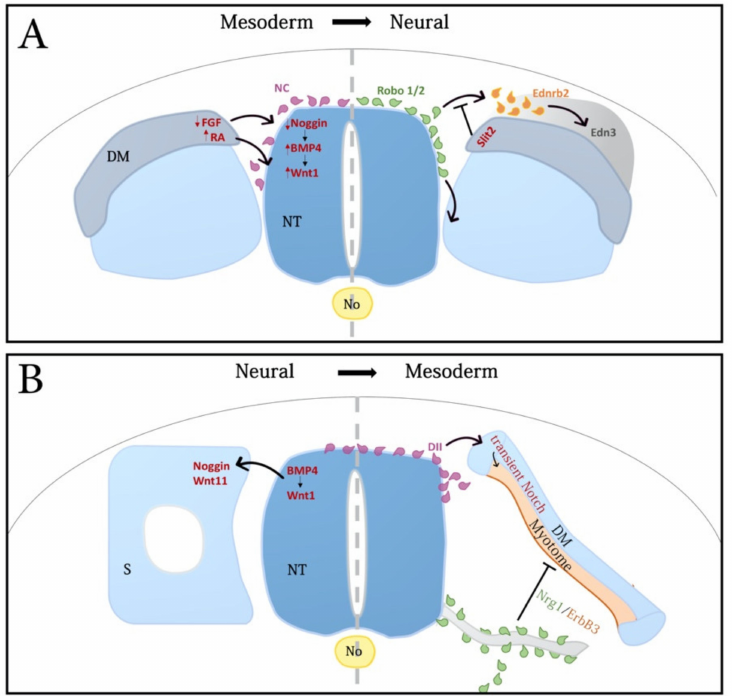
Figure 1. NC-mesoderm interactions. ( A ) Left side: The medial lip of the nascent dermomyotome (DM) controls the timing of NC delamination. In the early dorsal neural tube (NT), prior to the onset of NC emigration, levels of noggin are high, in part due to somite-derived FGF signaling, thereby inhibiting the activity of BMP4 and consequent NC delamination. During somite dissociation, decreasing FGF signaling results in reduced transcription of noggin in the dorsal NT. Consequently, inhibition on BMP4 is relieved, Wnt1 transcription is stimulated and NC emigration is set in motion. In parallel, increasing retinoic acid (RA) levels in the DM act upon the dorsal NT to induce Wnt1 and trigger NC cell emigration (purple cells). ( A ) Right side: The DM and later dermis influence the choice of pathways followed by NC cells. During the early stage of NC migration, DM cells express the secreted ligand Slit2, which acts upon Robo1/2-expressing NC cells (green) to prevent them from entering prematurely the dorsolateral pathway. At a later stage of migration, the Edn3 ligand, expressed in the somite-derived dermis and in the ectoderm attracts melanoblasts (yellow) that express the Ednrb2 receptor following delamination from the neural tube; this interaction guides them into the dorsolateral pathway. ( B ) Left side: The dorsal neural tube (NT) patterns the medial DM. NT-derived Bmp4 and Wnt1 signal the adjacent dorsal somite (S) to promote a medial identity, the development of the medial lip of the DM, and the expression of genes such as noggin and Wnt11, respectively. ( B ) Right side: Migrating NC cells regulate myogenesis. Migrating NC cells (purple) contact the dorsomedial lip of the DM and signal through Delta1 (Dll) to transiently activate Notch in the DM; this results in enhanced myogenesis at the expense of Pax7-positive progenitors in the epithelium. Migrating NC cells fated to become Schwann cells (green) along peripheral nerves signal through Nrg1/ErbB3 to the central and hypaxial DM and myotome (pink) to maintain the progenitor state while inhibiting myogenic differentiation. Stippled grey lines separate the NT in halves to illustrate different processes in each. See text for details and references. Abbreviations: No, notochord; Scl,